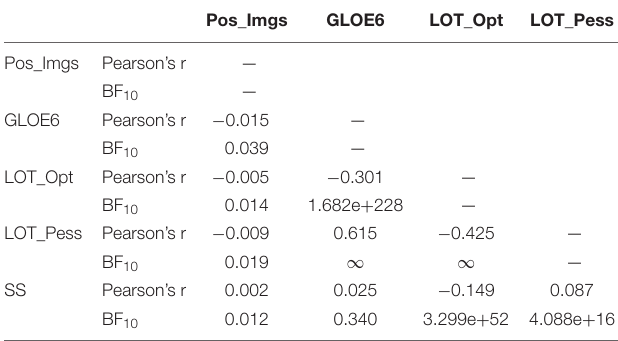
TABLE 3 | Bayesian Pearson correlations between number of positive stimuli and personality variables.